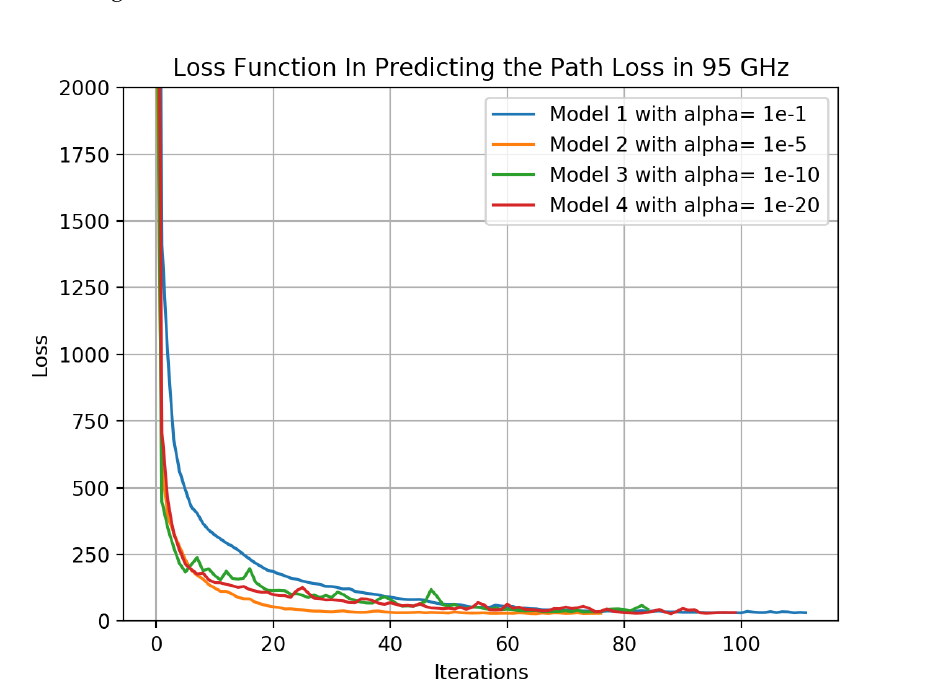
Figure 8. The loss of the deep learning models with different learning rate. Table 1 contains path loss predicting evaluation in the higher mmWave bands.